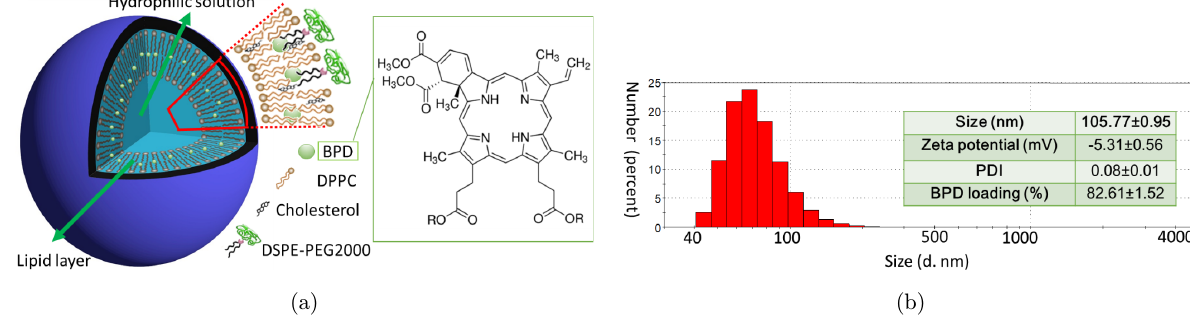
Fig. 3. (a) The schematic diagram illustrating LBPD. (b) The size distribution and the obtained characteristics (average size, average zeta-potential and percentage of the loaded BPD).